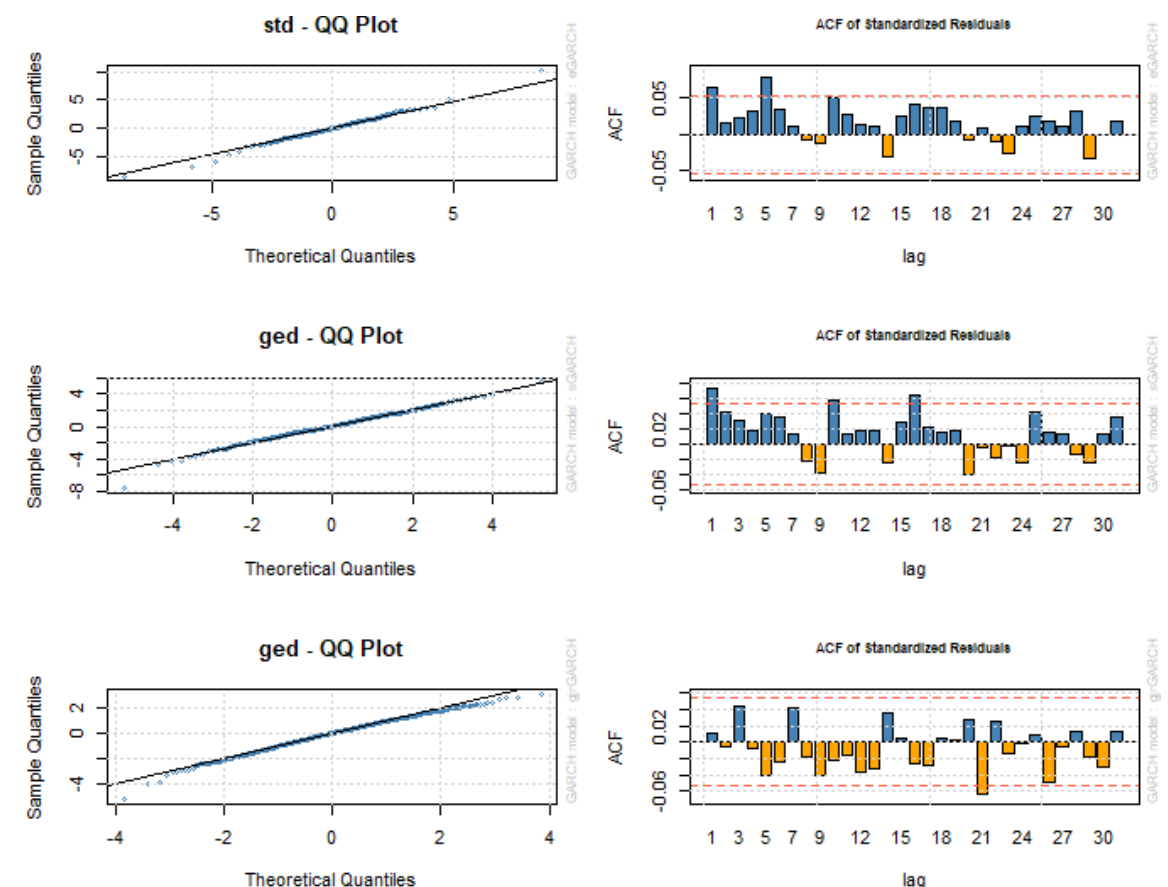
Figure 7. QQ plots and ACF plots for residuals for models with structural